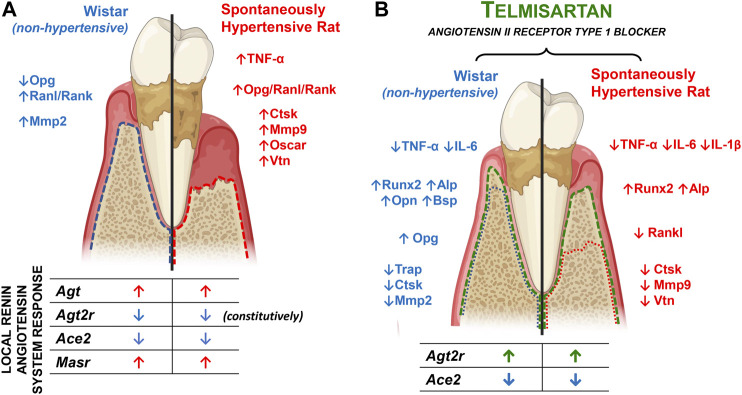
Main findings summary. (A) Main differences between Wistar (non-hypertensive) and SHR with PD. The blue and red dotted lines illustrate the alveolar bone loss in Wistar and SHR, respectively, the targets differentially expressed between the animal models are listed alongside, and the components of the local renin-angiotensin system altered by the PD are listed below. (B) Main effects of telmisartan in Wistar and SHR with PD. The green dotted line illustrates TELM protective effect in the PD-induced alveolar bone loss in Wistar and SHR, the related mechanisms are listed on the side, and the components of the local renin-angiotensin system altered by the treatment are listed below.